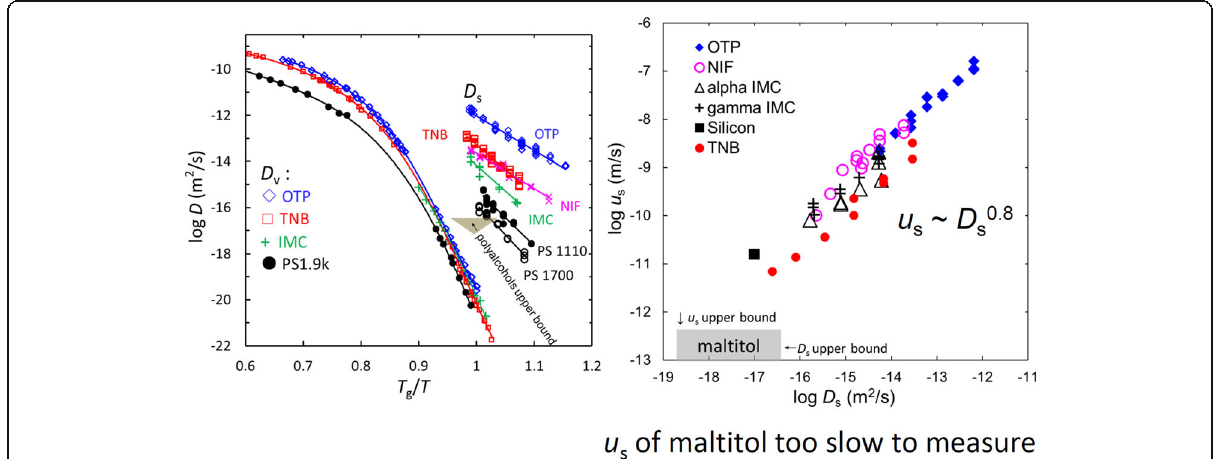
Fig. 2 Left : Bulk and surface diffusion coefficients (D v and D s ) plotted against T g /T. The D v values nearly form a master curve, whereas D s values have stronger molecular dependence. A D s upper bound from this work is shown for polyalcohols; Right : Correlation between the rates of surface crystal growth u s and surface diffusion (Adapted from Chen et al. 2016)